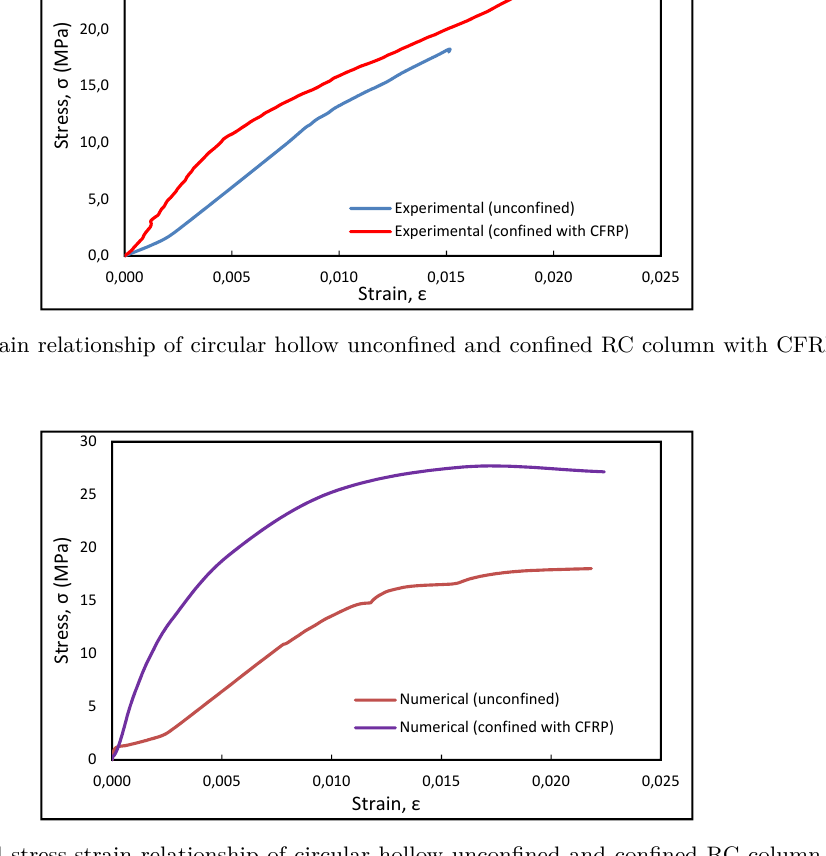
Figure 6. Predicted stress-strain relationship of circular hollow unconfined and confined RC column with CFRP under full axial load.